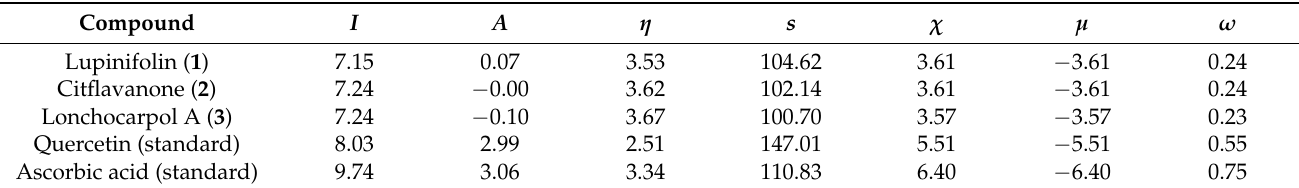
Table 1. The global descriptive parameters (in eV) of 1 – 3 and standard compounds at the B3LYP/6- 31+G (2d,2p) level of